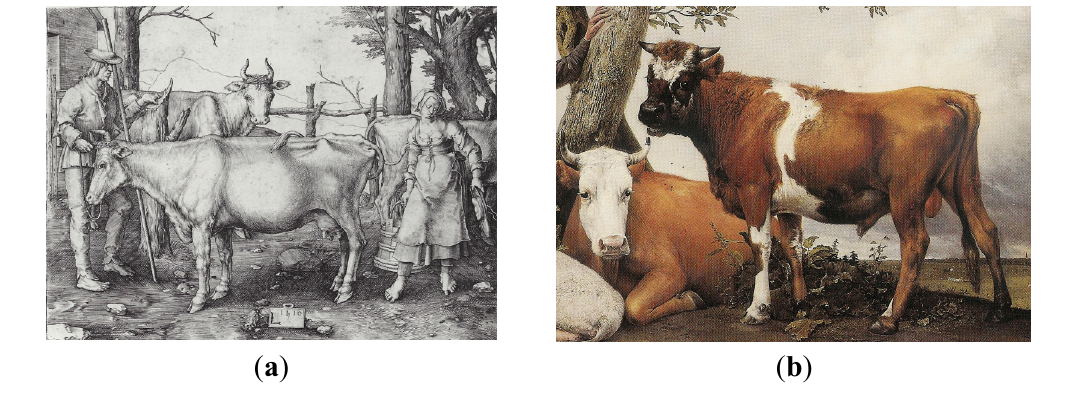
Figure 11. Contemporary depictions of preindustrial Dutch cattle . ( a ) The Milkmaid